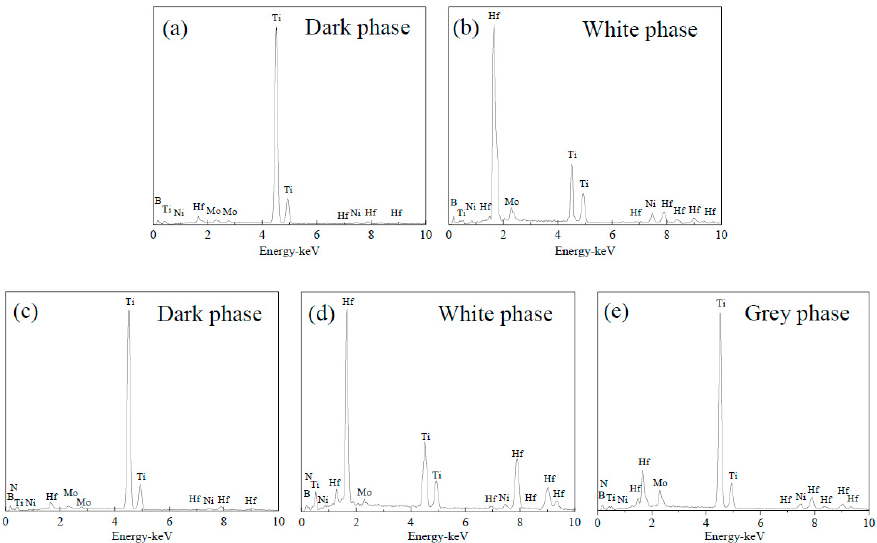
Figure 3. EDS of the phases in the TiB 2 -HfB 2 ceramic tool materials: ( a ) EDS of the dark phase; ( b ) EDS of the white phase, and EDS of the phases in the TiB 2 -HfN ceramic tool materials; ( c ) EDS of the dark phase; ( d ) EDS of the white phase; ( e ) EDS of the grey phase.